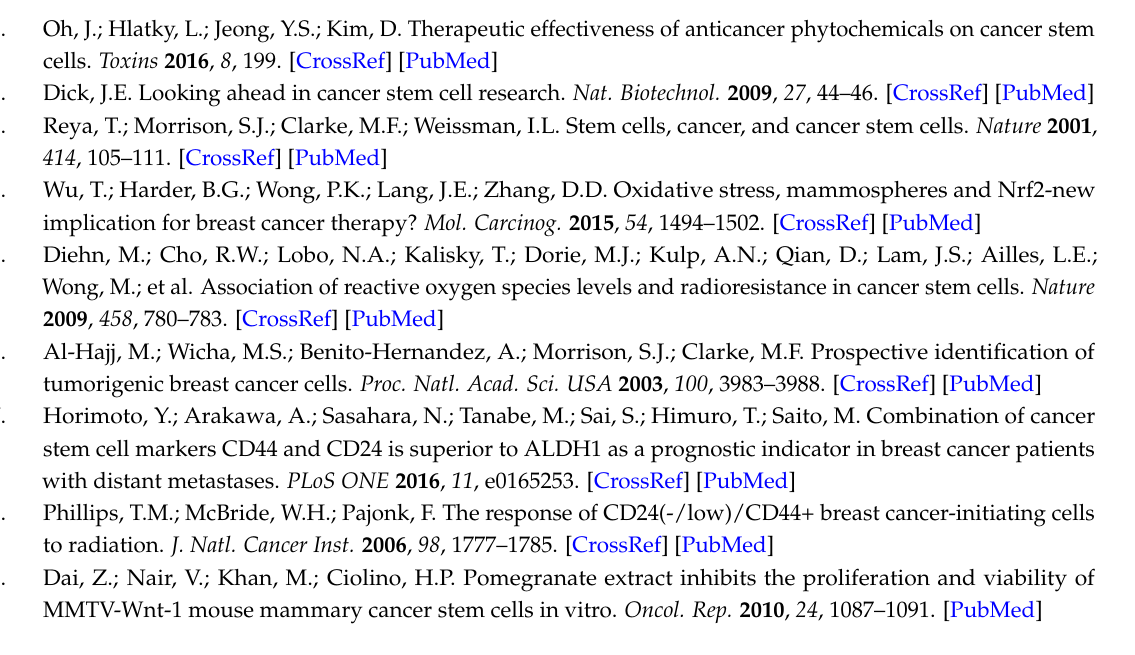
Figure S1: Various plant extract samples influencing ARE-luciferase activity, Figure S2: Cytotoxicity of chestnut leaf extract. MCF-7 cells were treated with the extract at various concentrations (0, 6.25, 12.5, 25, 50, 100, and 200 µ g/mL), Figure S3: Chestnut leaf extract facilitated paclitaxel-induced mitochondrial damage, a hallmark for apoptotic cell